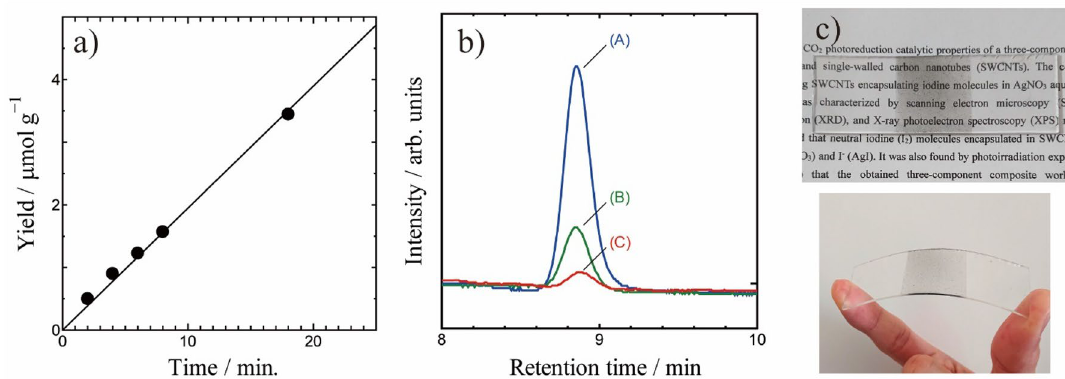
Figure 3. ( a ) Time dependence of CO yields over AgI-AgIO 3 -SWCNT under simulated solar light AM1.5G. ( b ) CO gas chromatography peaks of the AgI-AgIO 3 -SWCNT sample with (A) and without (B) UV-cut-filter. Data of pure AgI powder without UV-cut-filter (C) was also show as control experiment. ( c ) Transparent conductive film of AgI-AgIO 3